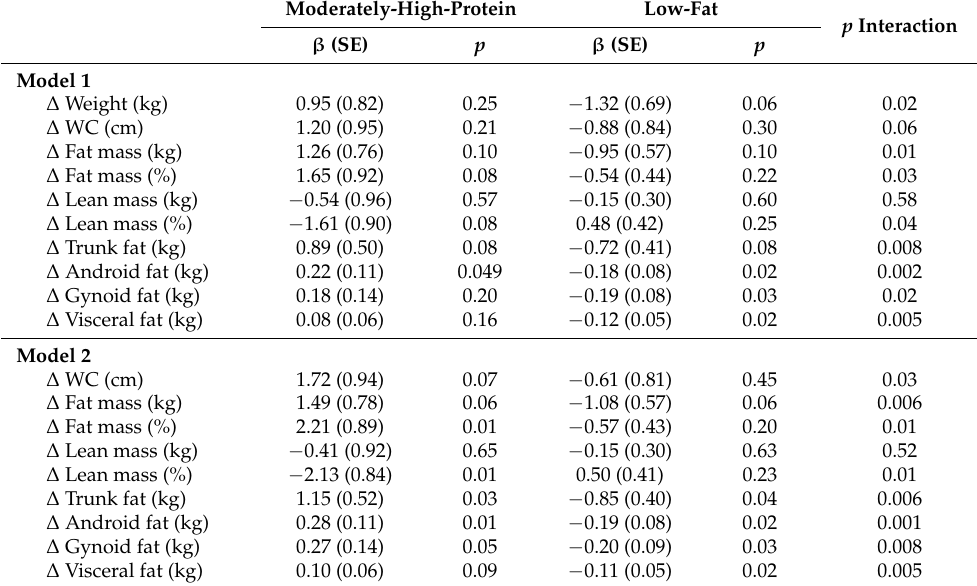
Table 4. Effect of the ADCY3 rs10182181 genetic variant on changes in body fatness and composition in response to moderately-high-protein/low-fat diet after 16 weeks of diet intervention (additive